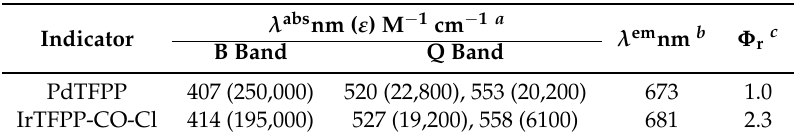
Table 1. Absorption peak wavelength ( λ abs ), molar absorptivity ( ε ), emission peak wavelength ( λ em ) and relative quantum yield ( Φ r ) of the indicators in chloroform and polystyrene films.